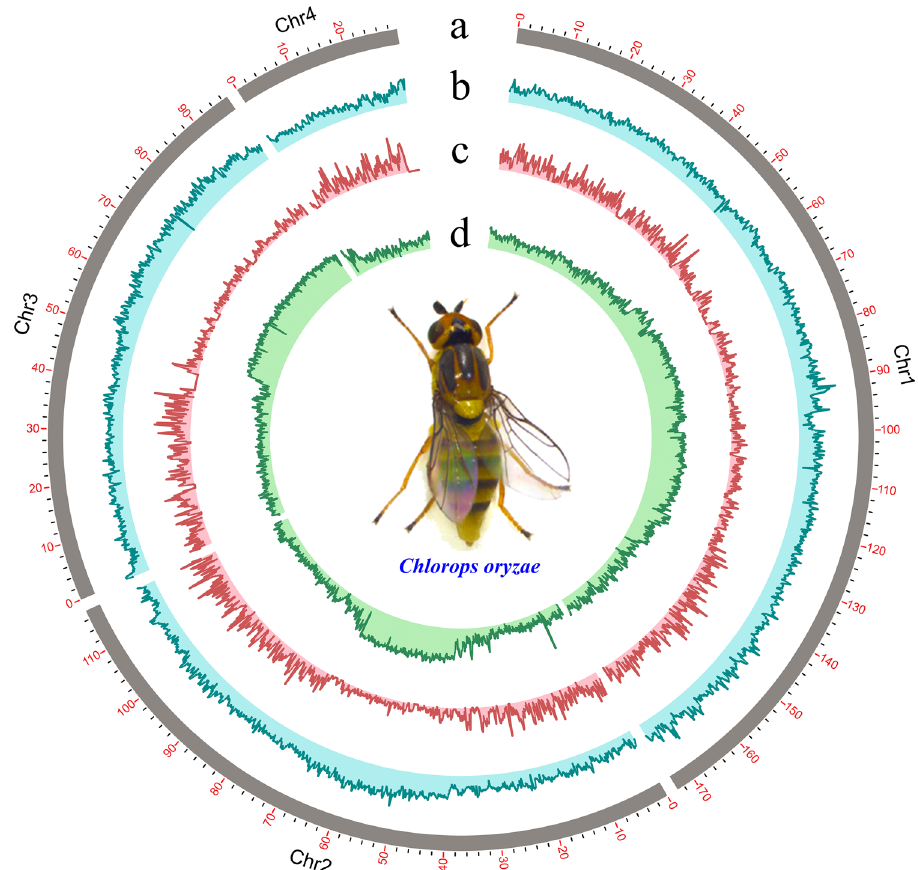
Fig. 2 Circular diagram depicting the characteristics of the Chlorops oryzae genome. From the outer to the inner circle: a 4 chromosome at the Mb scale; b GC concent across the genome, drawn in 0.1 Mb non-overlapping windows; c gene density across the genome, drawn in 0.1 Mb non-overlapping windows; d repeat density across the genome, drawn in 0.1 Mb non-overlapping windows. Table 1 Features of the Chlorops oryzae genome